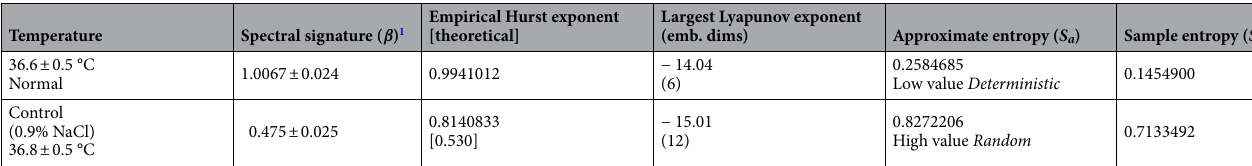
Table 1. Human blood. Multivariate analysis of the extracellular ion fluxes at a critical temperature—dynamic